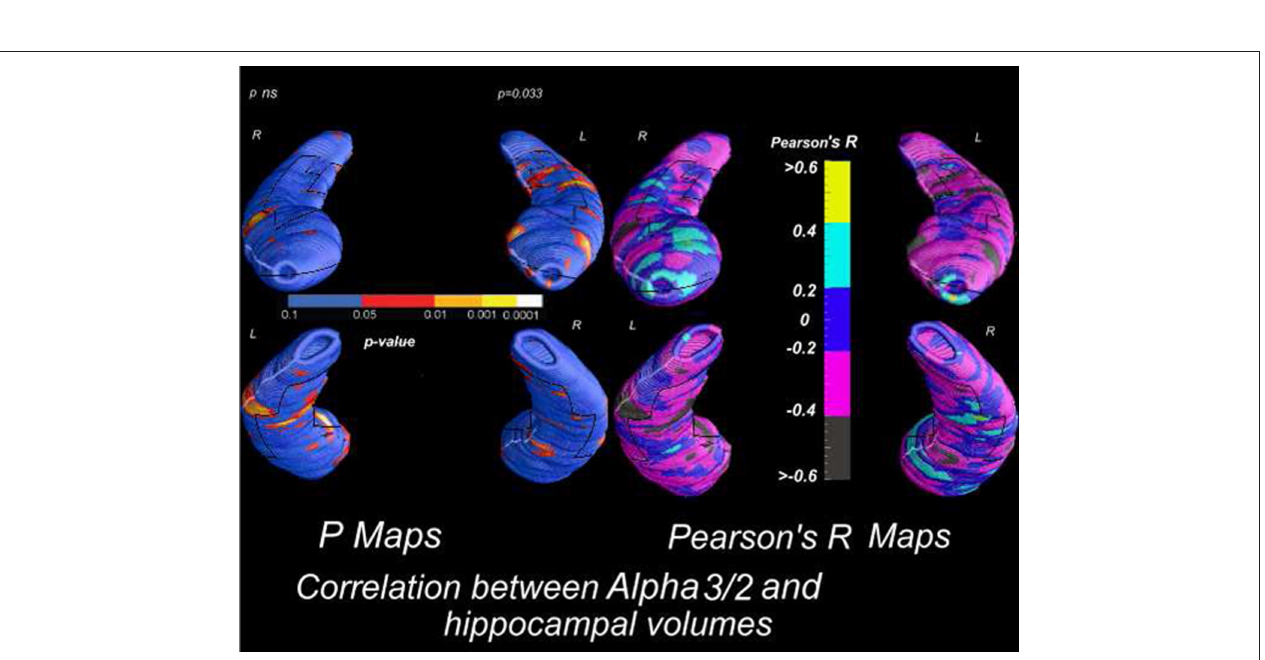
In particular, in AD patients the increase of both alpha3 rhythm spectral power and alpha3/alpha2 power ratio is correlated with the decrease of left hippocampal gray matter volumes. In particular, hip- pocampal areas involved in correlation are: presubiculum, dorsal and ventral subiculum, CA2–CA3 sectors of the body, CA1 mesial and